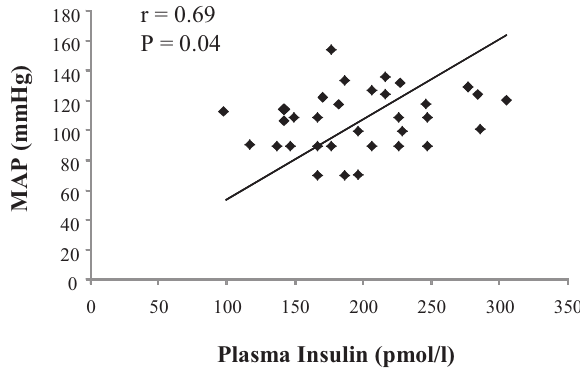
Figure 1 - Plasma insulin levels (A) during the OGTT in the control (C) and monosodium glutamate-treated (MSG) rats. In detail, the insulin area under the curve (IArea) for the control and MSG groups (B). * p= 0.05.